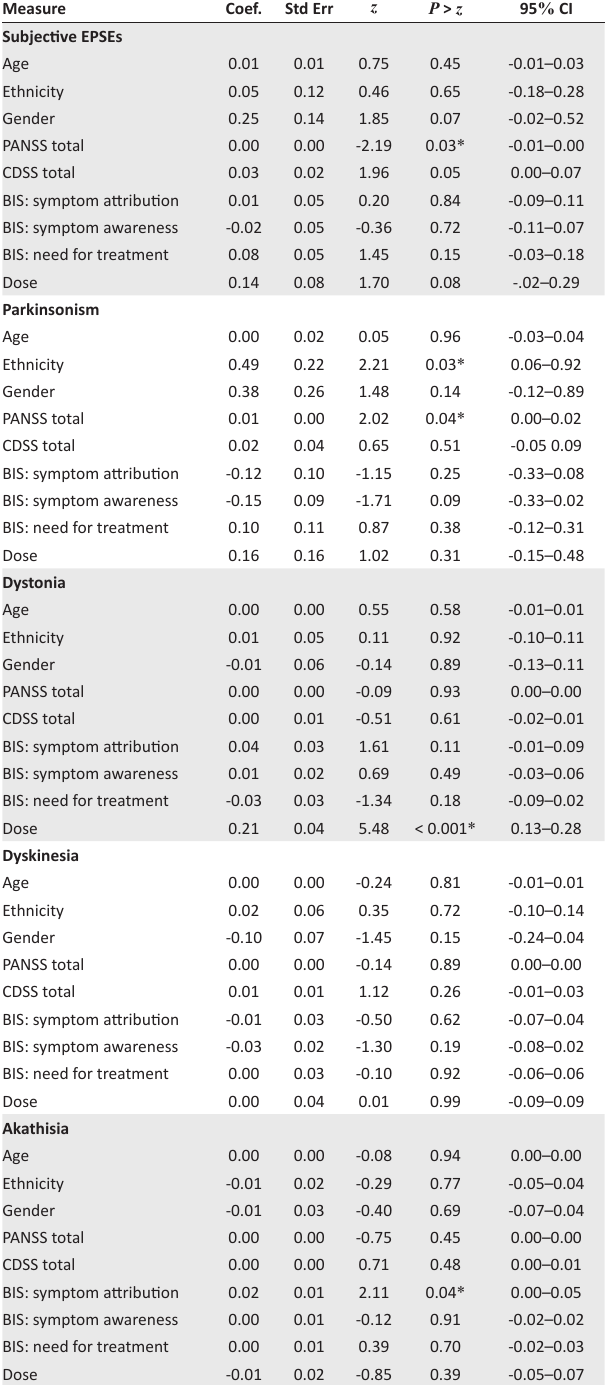
Table 1-A1: Linear mixed effect repeated measures model describing the relationship between EPSEs and clinical and demographic characteristics. Measure Coef. Std